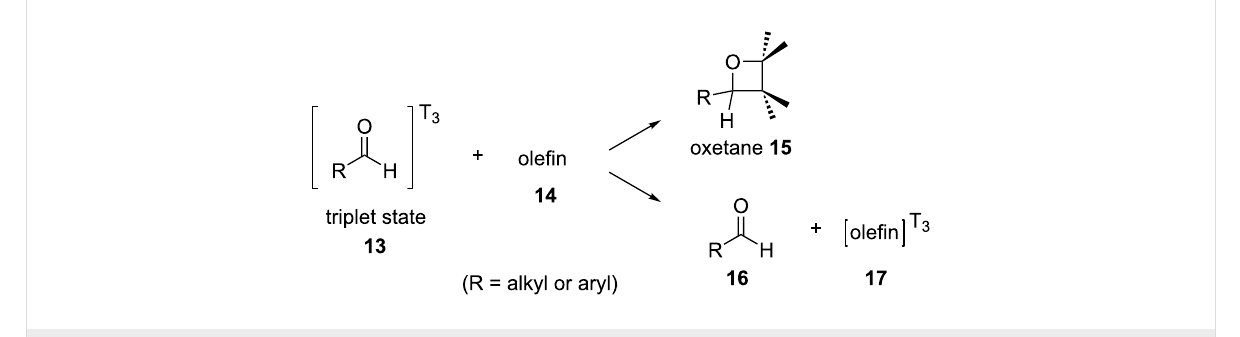
Scheme 3: Aldehydes in the Paterno–Büchi reaction.